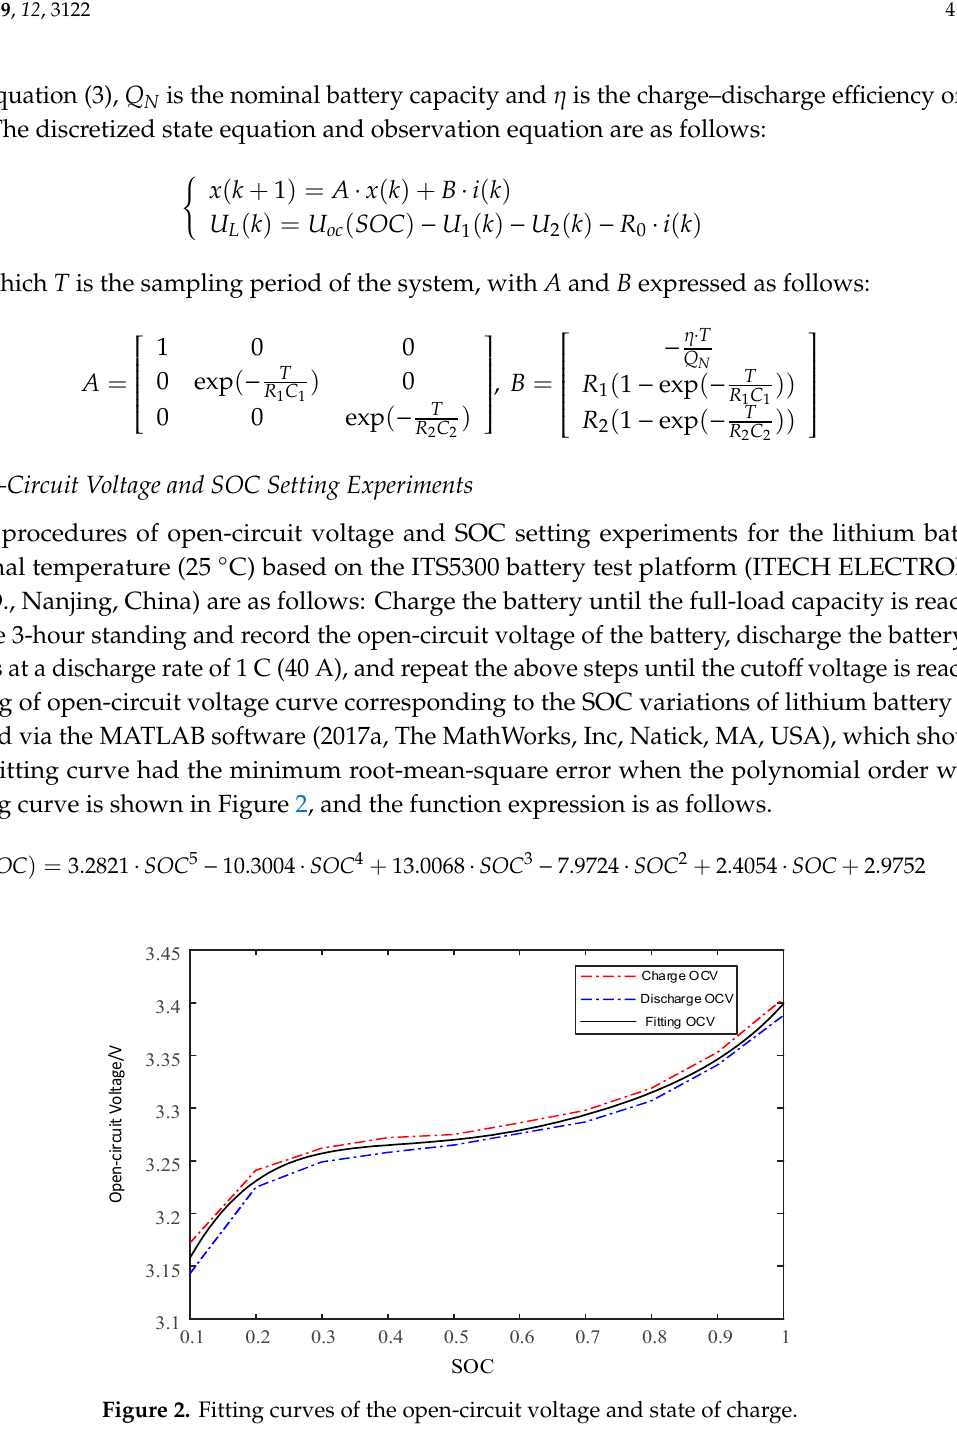
Figure 2. Fitting curves of the open-circuit voltage and state of charge.